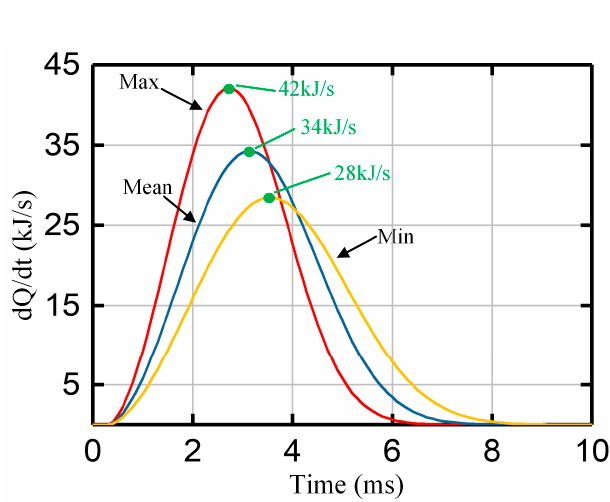
Figure 7. Fluctuation of heat release rate.